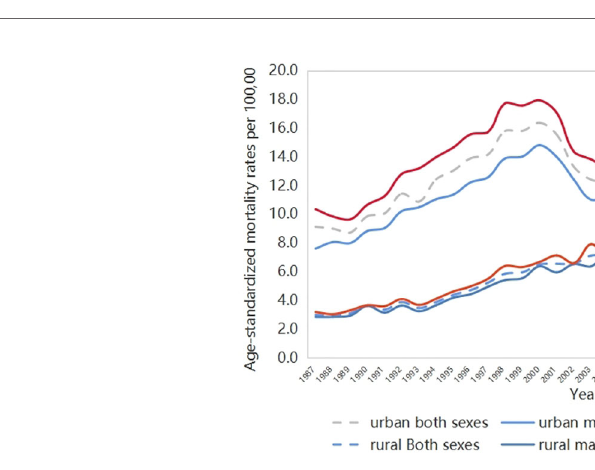
FIGURE 2 | Trend of age-standardized mortality rates of diabetes in China 1987